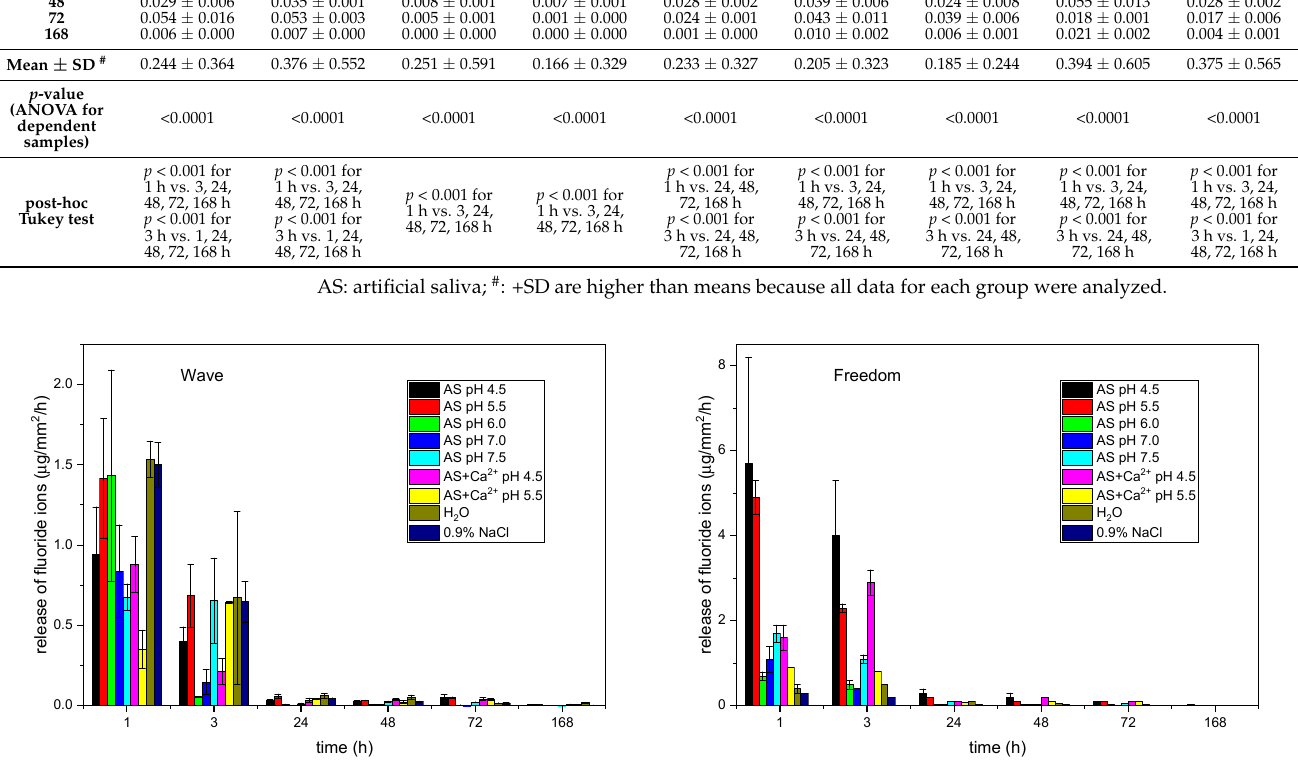
Figure 5. Release of fluoride ions ( µ g/mm 2 /h) from composite Wave ( left ) and compomer Freedom ( right ) into nine different solutions. AS: artificial saliva.